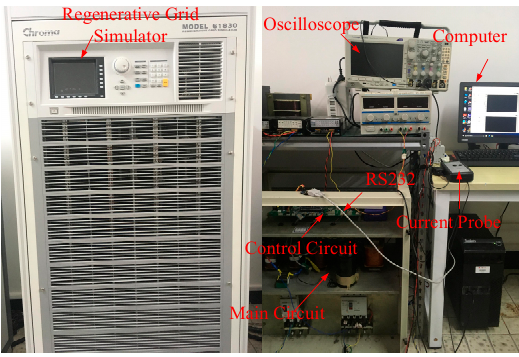
Figure 18. Platform of the grid-tied inverter for single phase.